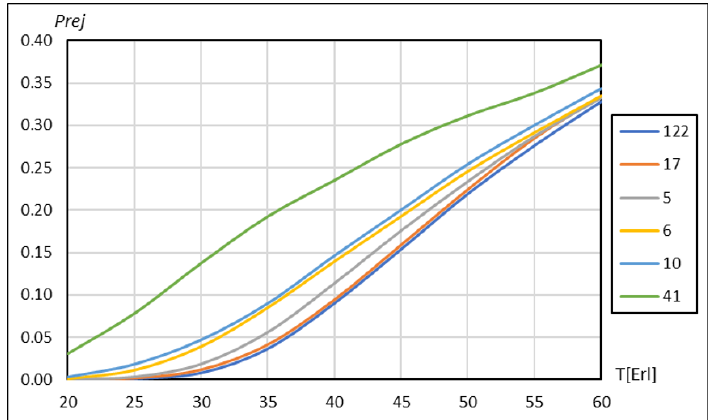
Figure 3. Results of simulations for chosen graphs.